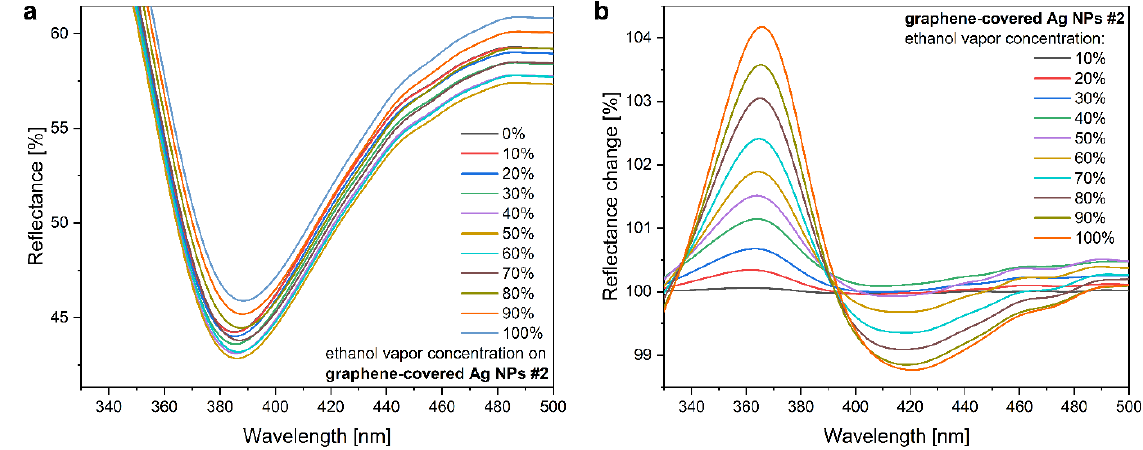
Figure 4. ( a ) LSPR shift of graphene-covered Ag NPs (sample #2) for different concentrations of ethanol vapor. The initial spectrum (0%) measured in synthetic air was used as a reference. ( b ) Reflectance change spectra, calculated from the same measurements (see main text).